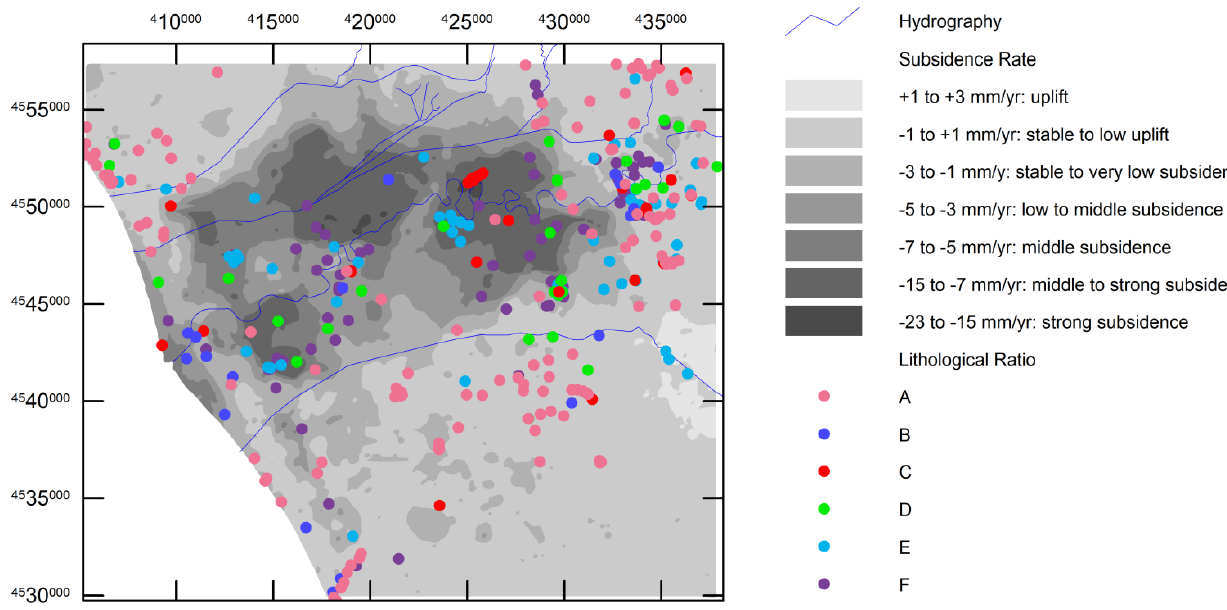
Figure 7. LR vs. subsidence values.